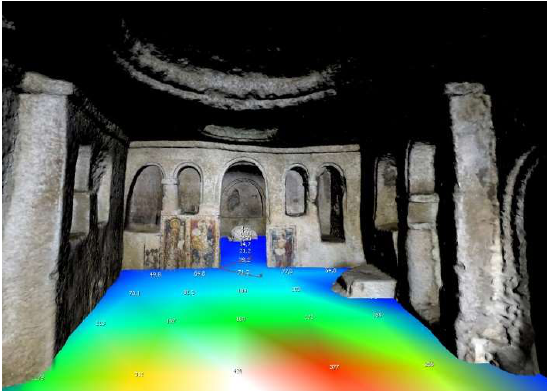
Figure 7: 3D Studio Max Sw. Lightmeter for lighting analisys. Daylight in the nave -h 12.00 - Date: 21 June 2018